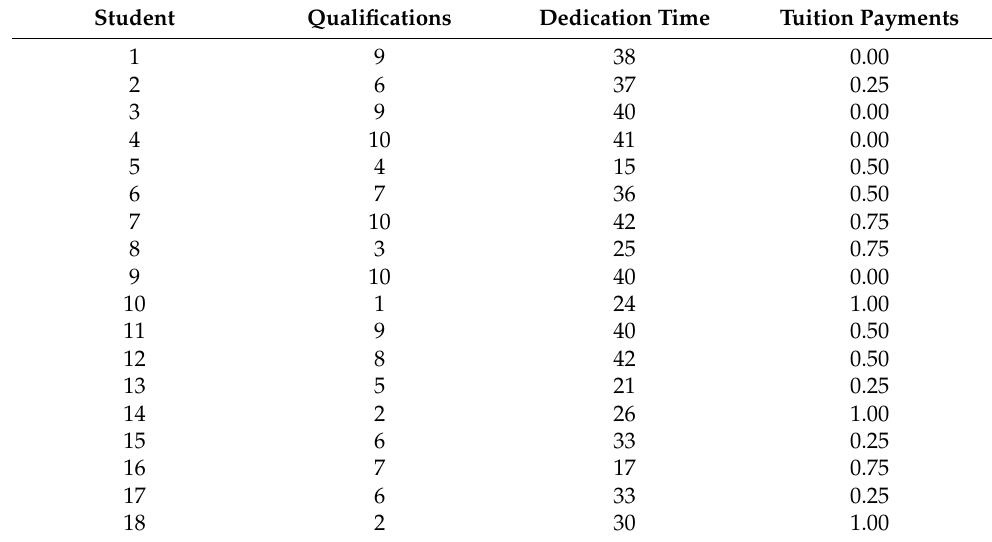
Table 1. Ratings results vs. time of dedication and financial problems for the payment of tuition. Student